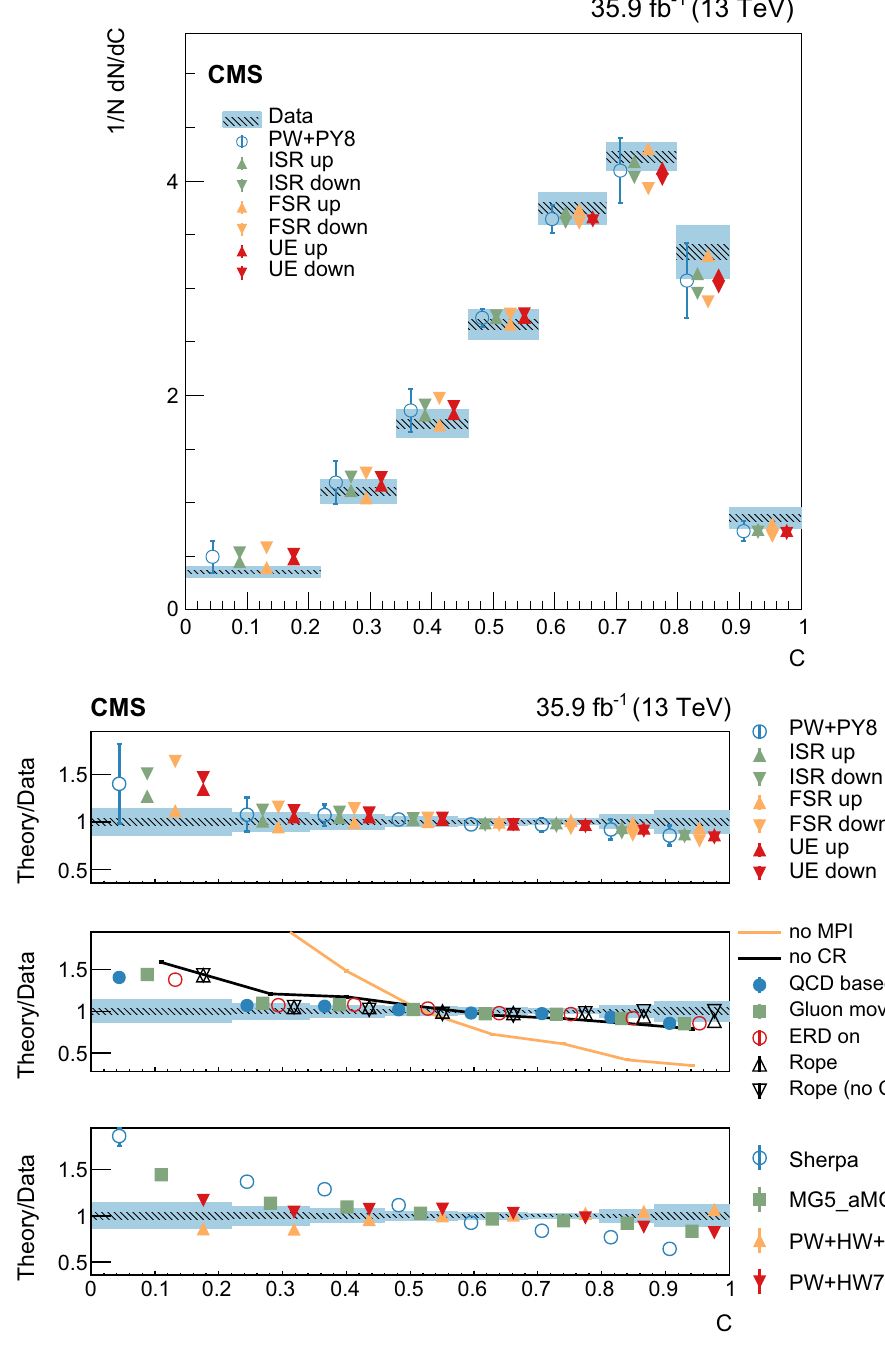
Fig. 12 Normalized differential cross section as function of the C variable, compared to the predictions of different models. The conventions of Fig. 4 are